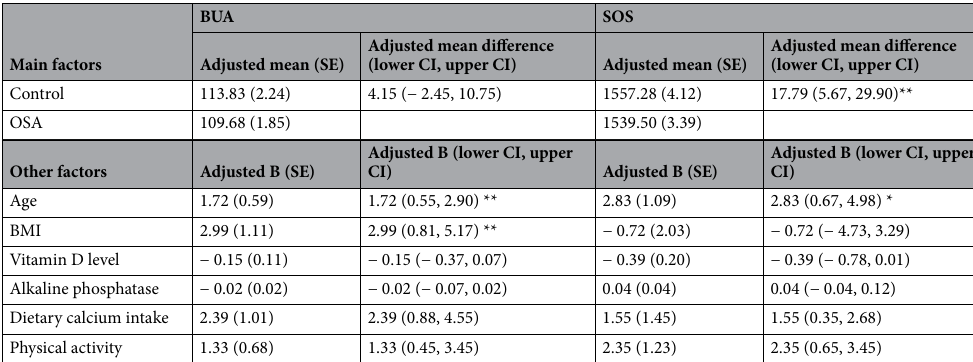
Table 5. Multiple variables multivariate covariance analysis (MANCOVA) on BUA and SoS (n = 150). Adjusted R 2 for BUA = 0.107; adjusted R 2 = for SOS = 0.153. SE standard error, B regression coefficient, CI confidence interval. *p < 0.05. **p <